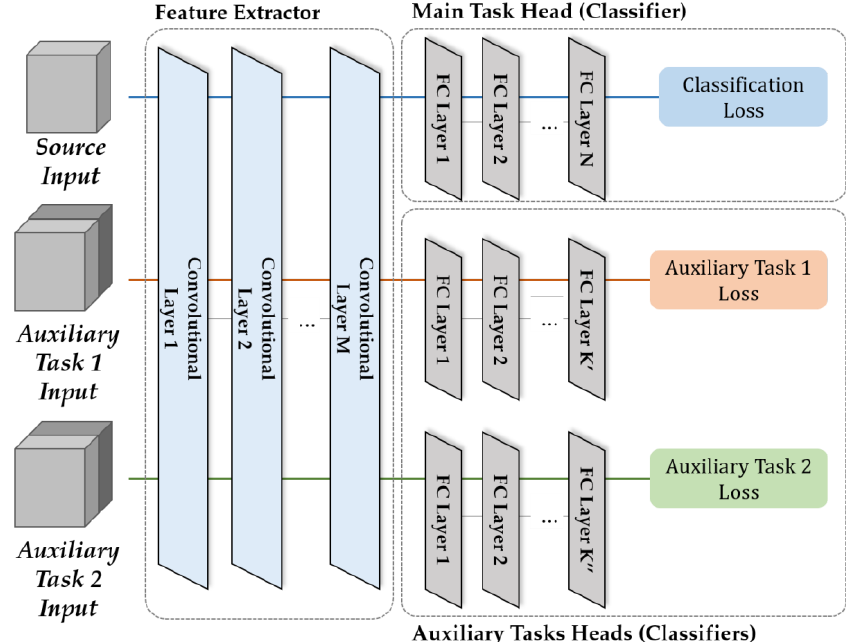
Figure 7. The architecture of self-supervision-based domain adaptation.